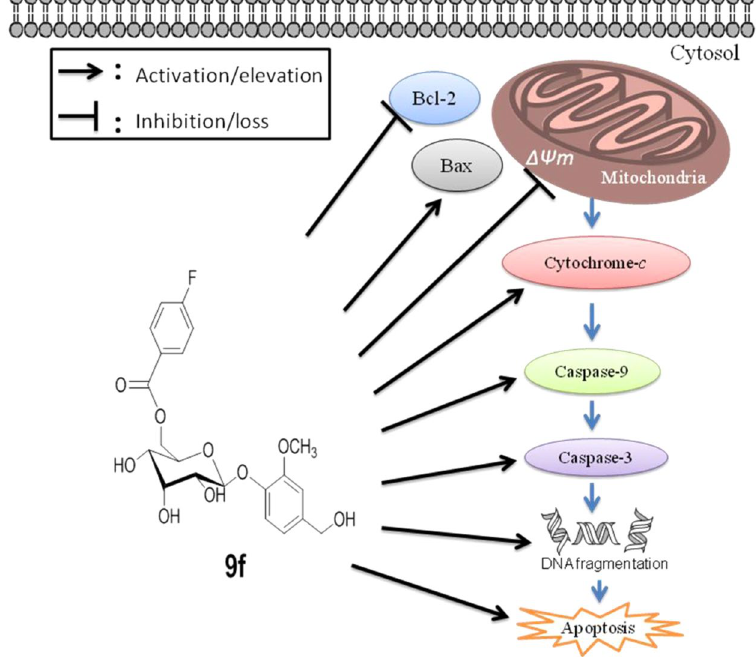
Figure 7. A diagram represents that 9f-induces apoptosis in MCF-7 breast and HL-60 cancer cells through mitochondria-mediated intrinsic pathway. 9f inhibits Bcl-2 levels and elevates Bax protein levels that may causes mitochondrial membrane potential ( Δψ m) loss and release of mitochondrial cytochrome c into cytosol, followed by activation of caspases 9 and 3 and DNA